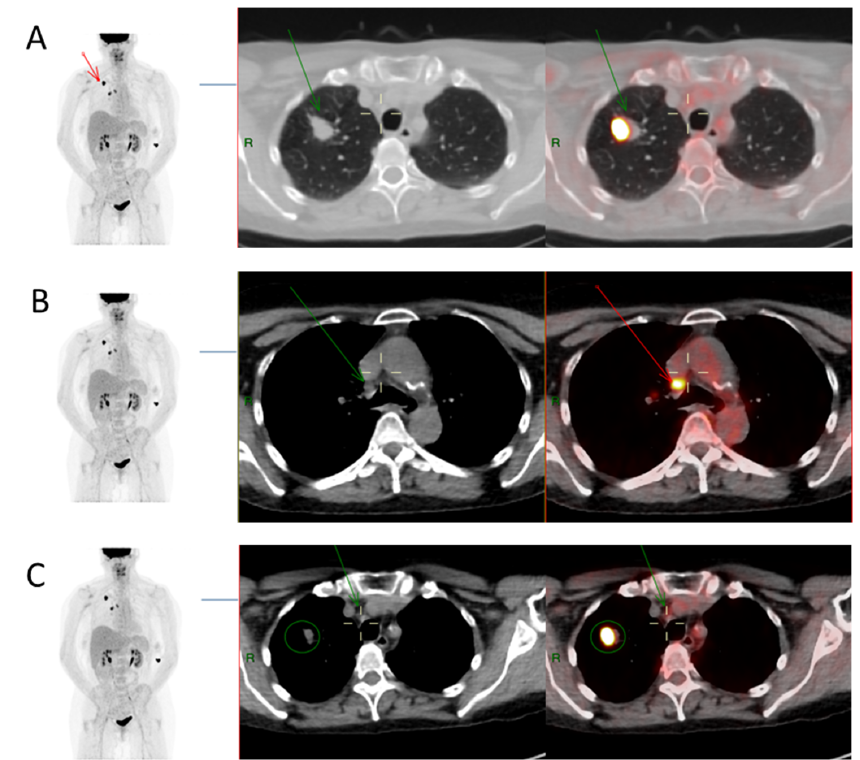
Figure 1. Extracted images from FDG PET/CT scan of a single patient (Case #52). ( A ) Primary tumour—FDG PET/CT images showing a right upper lobe tumour (red arrow in image on left and green arrow in Axial CT and fused PET/CT images) with measured SUVmax value of 26.1. SUVmax was also obtained from reference background structures: mediastinal blood pool (ascending aorta), SUVmax 2.9; and liver (right lobe), SUVmax 4.5. ( B ) Positive mediastinal lymph node on histology— SUVmax of mediastinal nodal station 4R (7 mm right lower paratracheal node, green arrow) was 8.0, hence SUV ratios of MR (8/2.9 = 2.8), LR (8/4.5 = 1.8), TR (8/26.1 = 0.3), and SR (8/7 = 1.1). 4R right upper paratracheal node, green arrow) has SUVmax value of 2.5, giving SUV ratios of MR